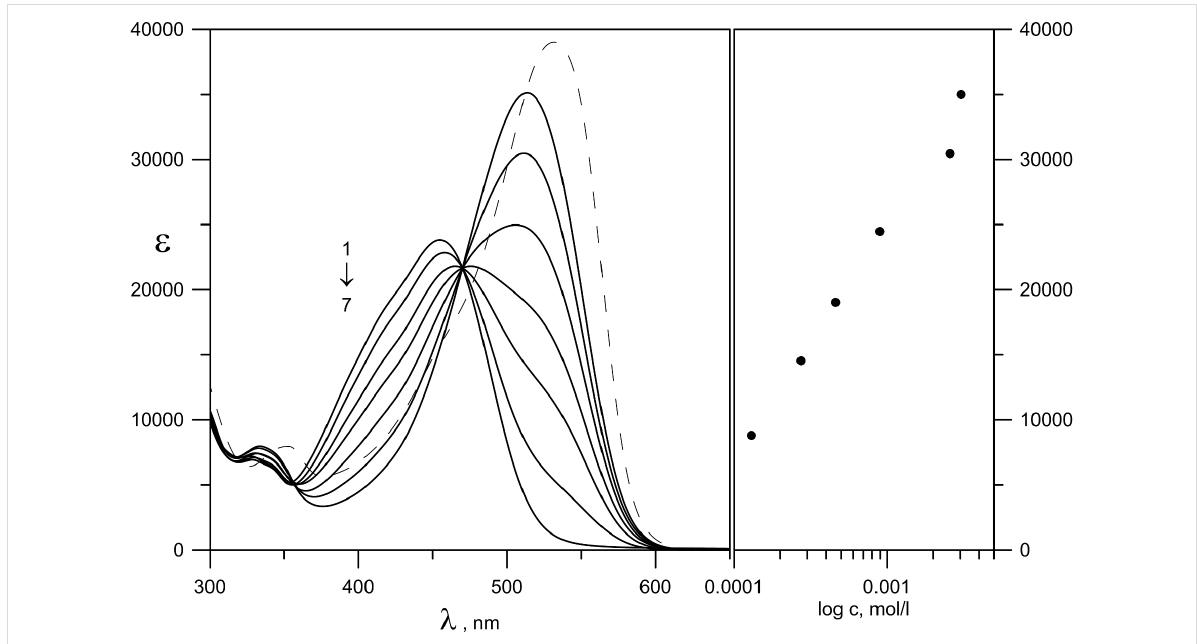
Figure 4: Left: Absorption spectra of 6 with stepwise addition of Mg(ClO 4 ) 2 in acetonitrile (1 – neutral ligand; 7 – complex C Mg(ClO4)2 = 1.23 × 10 − 3 M. The spectrum of the deprotonated form of 6 is drawn with dashes. Right: Molar absorptivity at 513 nm as a function of the concentration of the salt in a logarithmic scale.